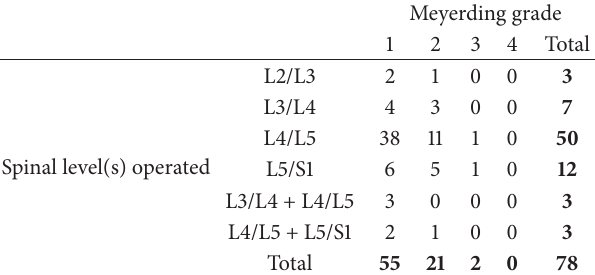
Table 1: Box chart of spinal levels operated and Meyerding grade.